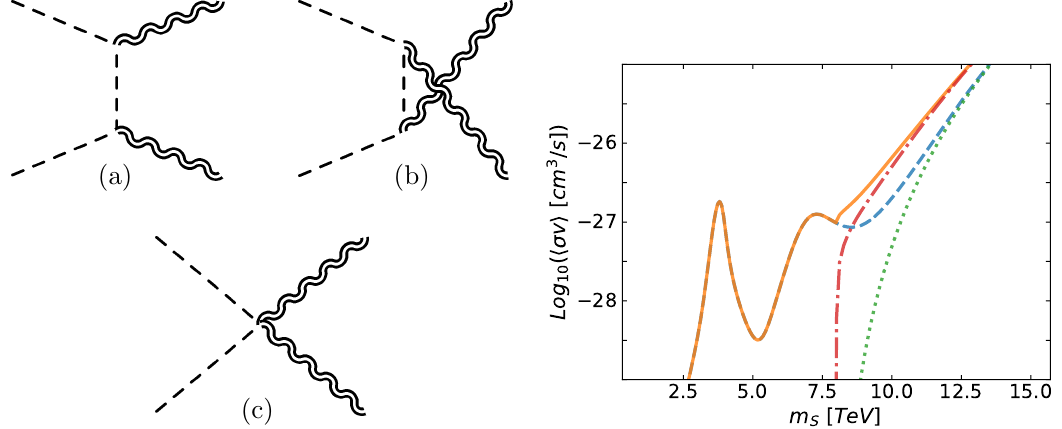
Figure 2 . Left panel: Feynman diagrams corresponding to the di(cid:11)erent amplitudes that contribute to scalar DM annihilation into two on-shell KK-gravitons at O (1 = (cid:3) 2 ). Diagrams (a) and (b): t - and u -channel DM exchange. Diagram (c): second order expansion of the metric in eq. (2.7). Right panel: Relevance of overlooked contributions to the scalar DM annihilation cross-section for (cid:3) = 10 TeV and m G = 8 TeV, as a function of the DM mass m S . The solid orange (blue 1 dashed) line corresponds to the DM annihilation cross-section through and into KK-gravitons with (without) the contribution to the amplitude from diagram (c). The dot-dashed red (dotted green) line is the DM annihilation cross-section into KK-gravitons, only, with (without) the contribution from diagram